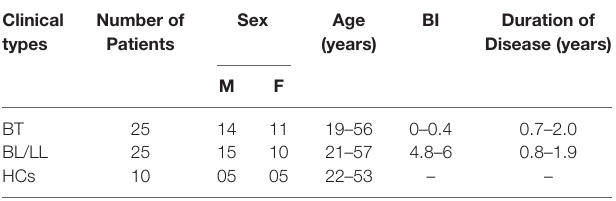
TaBle 1 | Clinical details of 50 newly diagnosed untreated leprosy patients and 10 HC